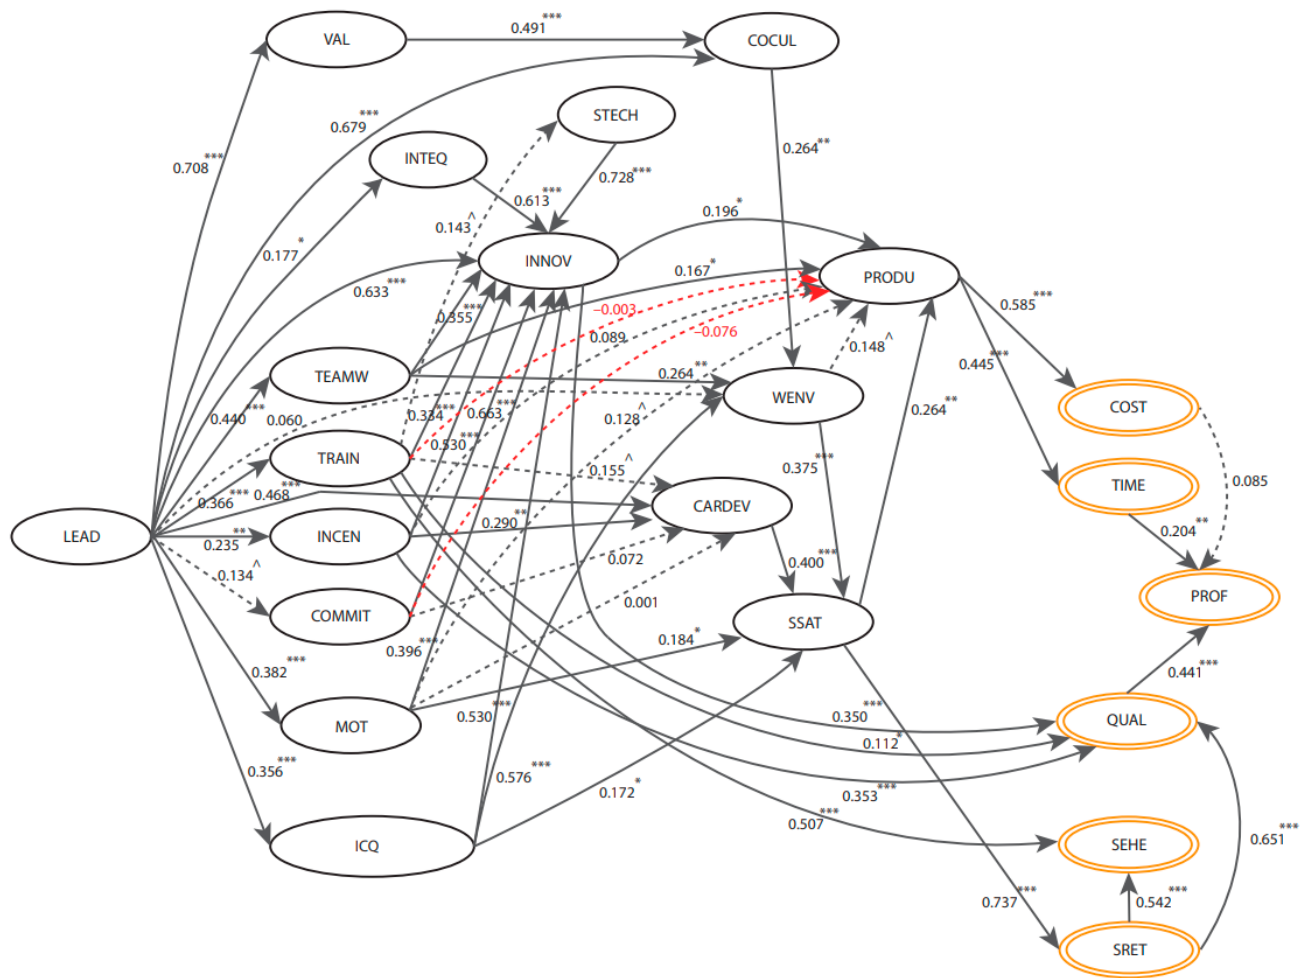
Figure 5. PLS model for Human Resources, which represents the direct e ff ects and the p -value; the smaller the value, the more reliable the results of the study *** p < 0.01, ** p < 0.05, * p < 0.1, ^ p <